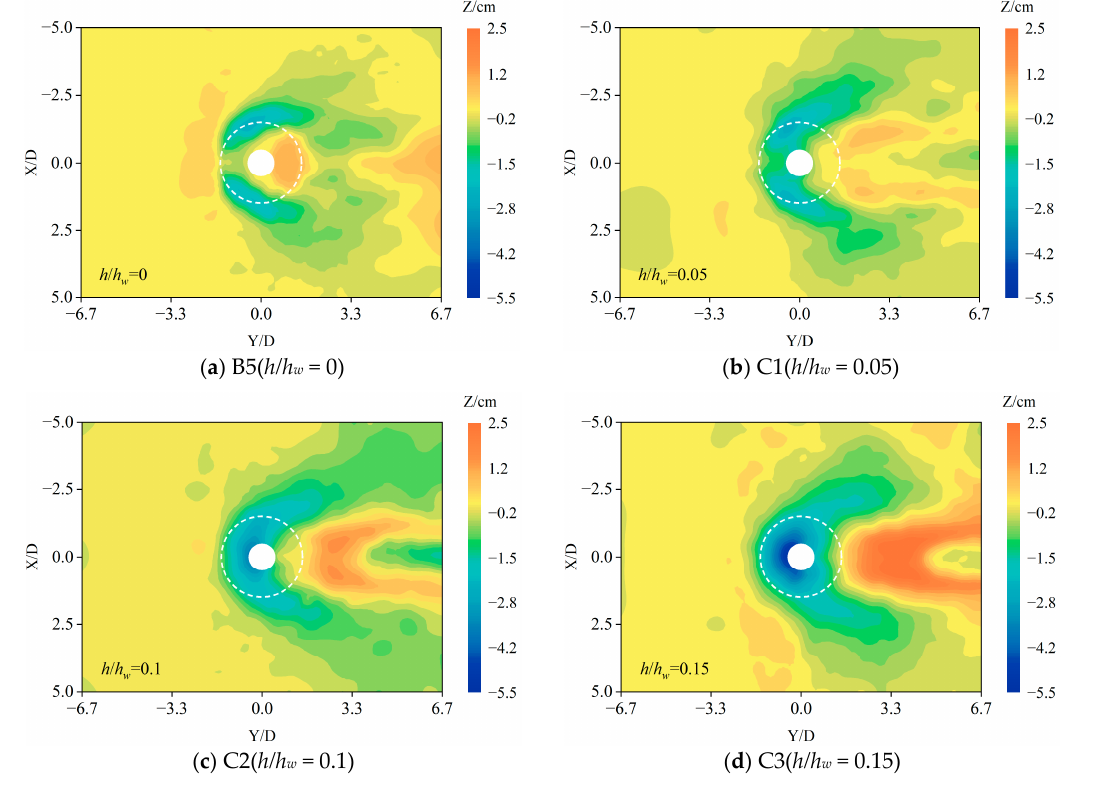
Figure 12. Local scour around the pier using the permeable collar with different installation heights. Table 3. Maximum scour depth around the pier using the permeable collar with different installa- tion heights.